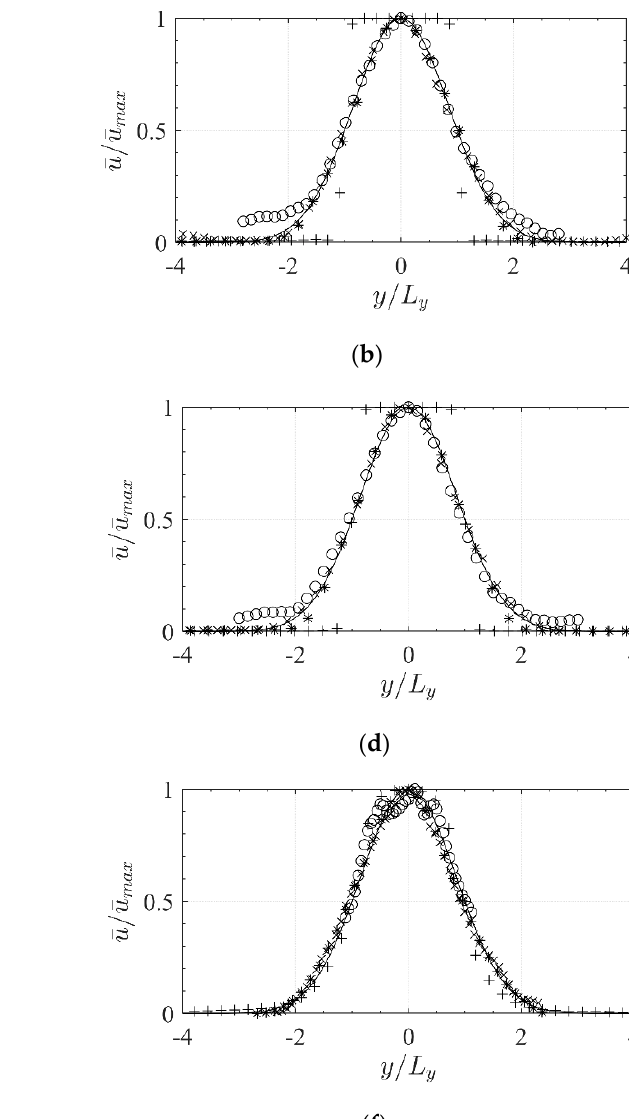
( a ) ch-rans ; ( b ) ch-des ; ( c ) sh-rans ; ( d ) sh-des ; ( e ) si-rans ; ( f ) si-des .